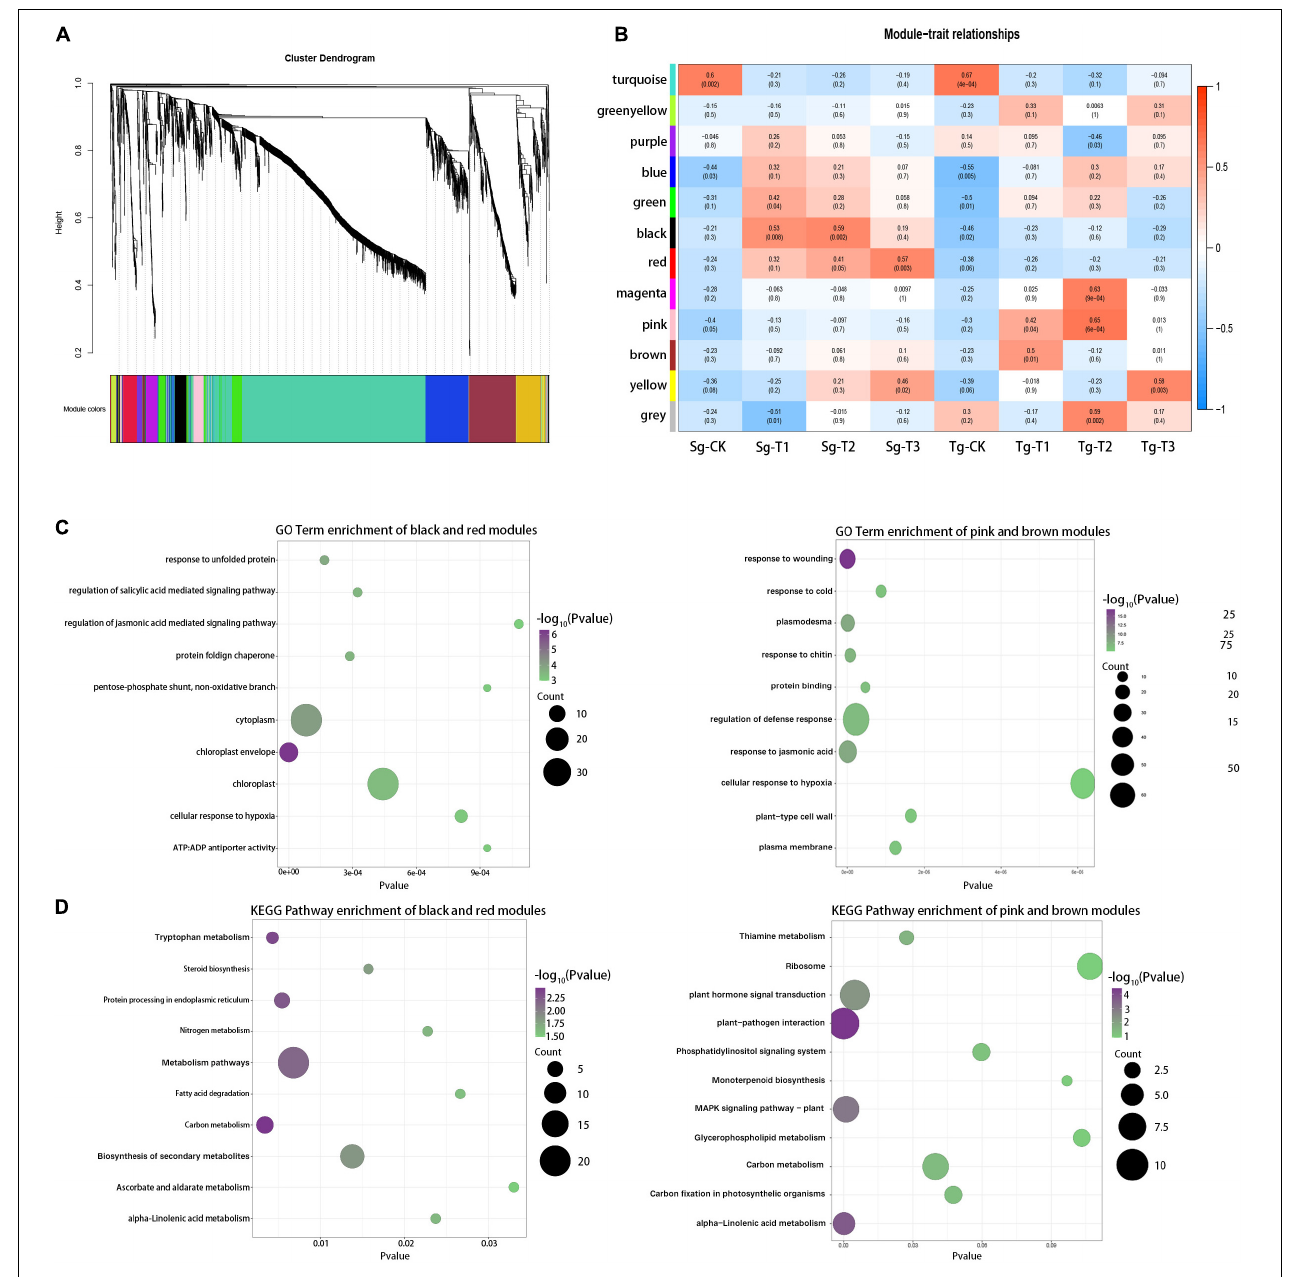
FIGURE 5 | Weighted gene network analysis of the response of the genes to cold. (A) Twelve modules of co-expressed genes are shown on the hierarchical cluster tree. Each branch represents a DEG. (B) Correlations of the gene expression modules, the two populations, and the 0 (CK), 4, 8, and 24 h treatments. Red and blue indicate the positive and negative correlations, respectively. The correlation coefficient and the p -value are shown within each cell. (C) Top 10 enriched GO terms of the Sg and Tg C. japonica modules within the highest correlation; bubble color indicates the -log10( p ) value of the enriched GO term. (D) Top 10 enriched KEGG pathways of the Sg and Tg C. japonica modules with the highest correlation; bubble color indicates the -log10 ( p ) value of the enriched KEGG pathways. The pathways of concern are marked in